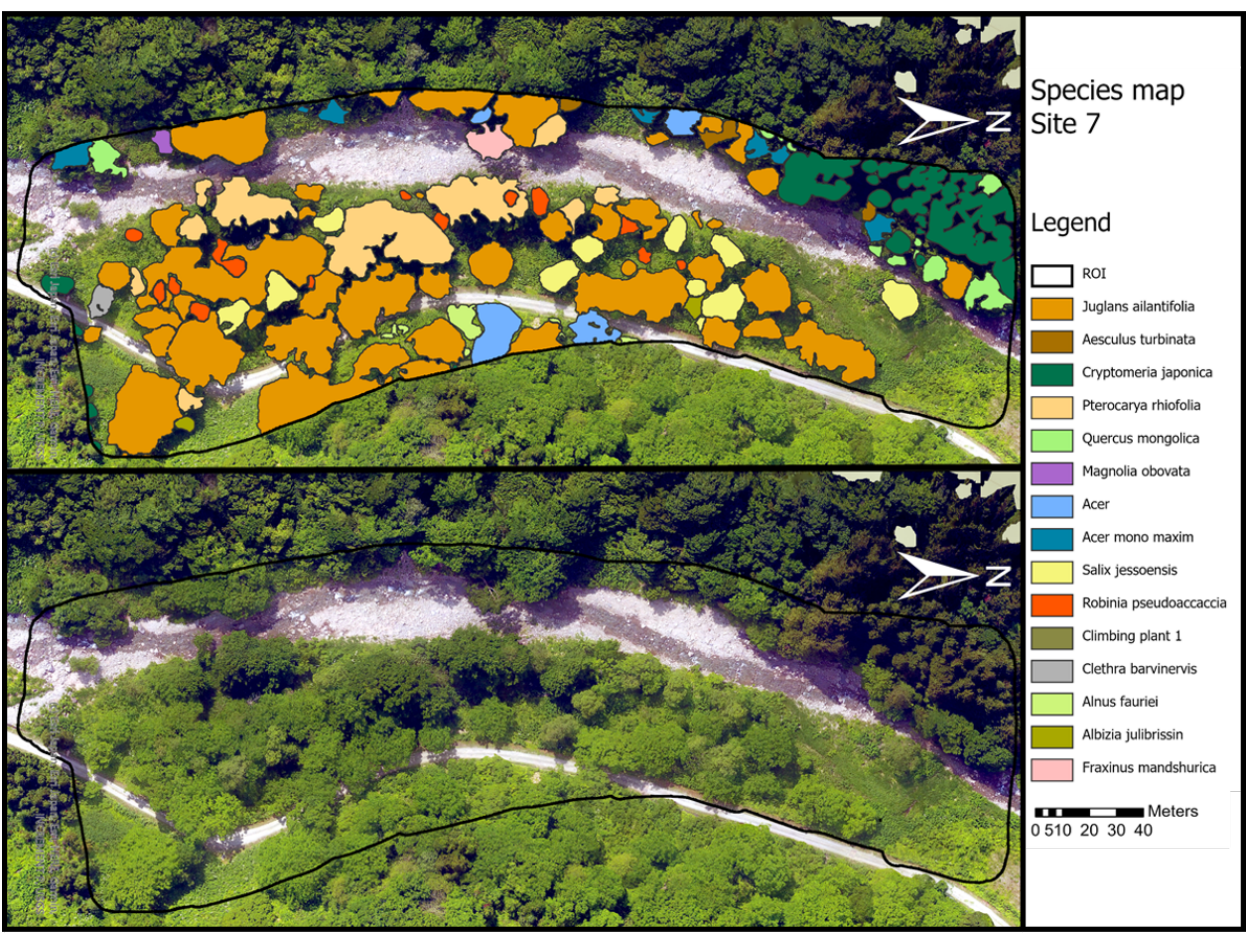
Figure 7. Example of the tree species classification. ( Up ), manually annotated tree species. ( Down ), original orthomosaic corresponding to a natural mixed forest in Tsuruoka